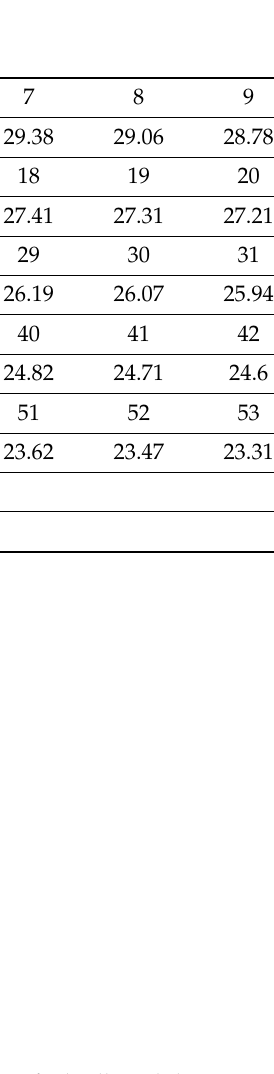
Figure 8. Obtained experimental ( i–v ) characteristics of the Nexa 1200 fuel cell module.